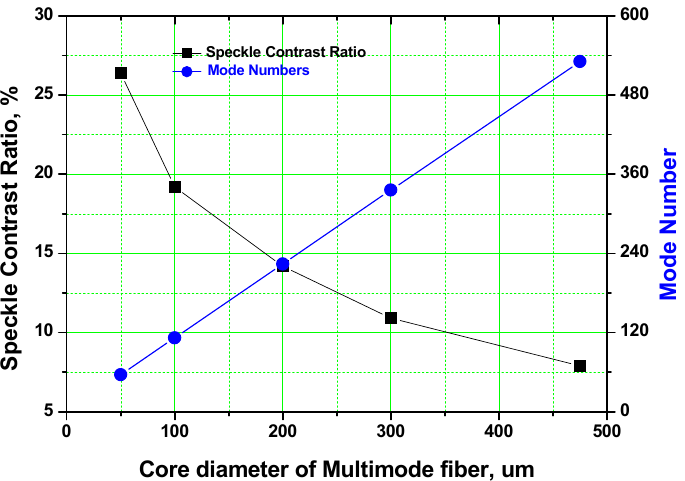
Figure 6. The speckle contrast ratios and mode numbers versus the core diameters of the multi-mode quartz fiber.